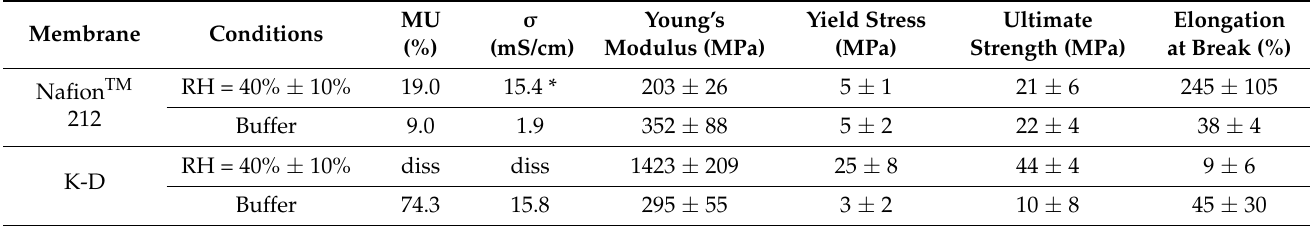
Figure 3. Typical stress-strain curves at relative humidity (RH) = 40% ± 10% and after immersion in buffer solution of ( a ) K-D and ( b ) Nafion 212 membrane. Table 3. Mass uptake (MU), ionic conductivity, σ, and mechanical properties after conditioning in humid air or buffer solution at room temperature (RT). * in fully hydrated conditions.